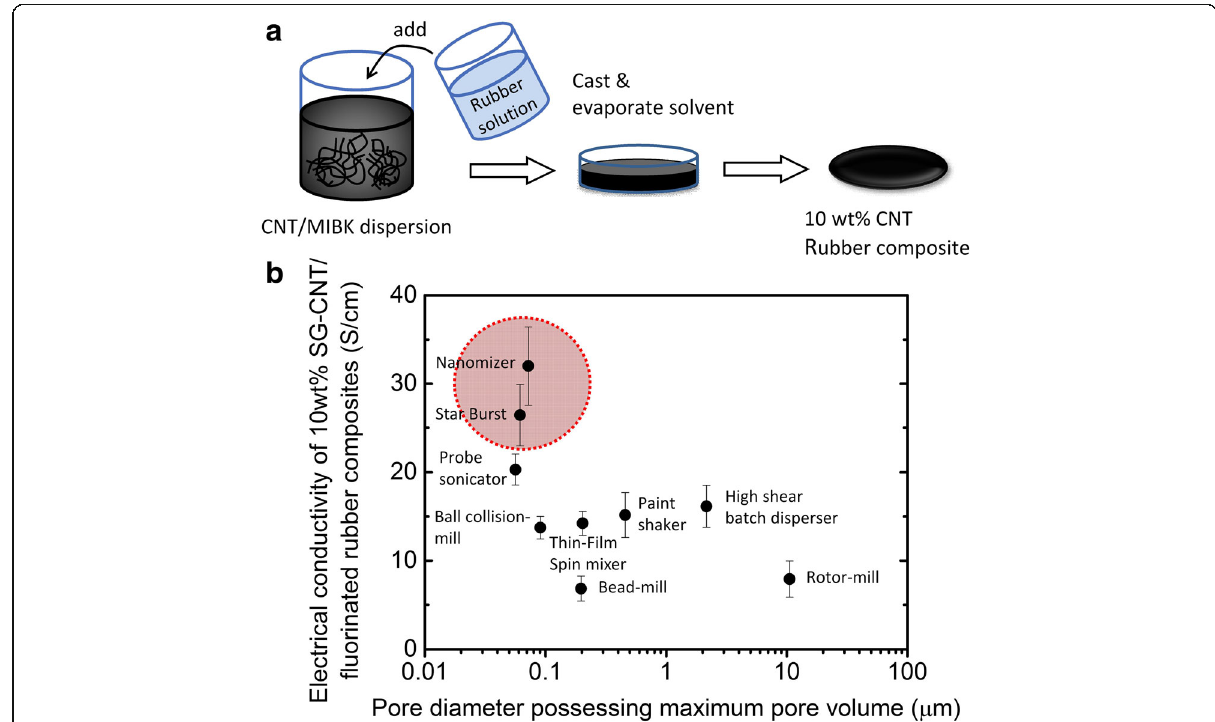
Fig. 5 Correlation between pore sizes for SG SWNT Buckypapers and electrical conductivity of SG SWNT/rubber composites. a Schematic for making a 10 wt% CNT/rubber composite. b Their electrical conductivity as a function of pore diameter possessing maximum pore volume for their